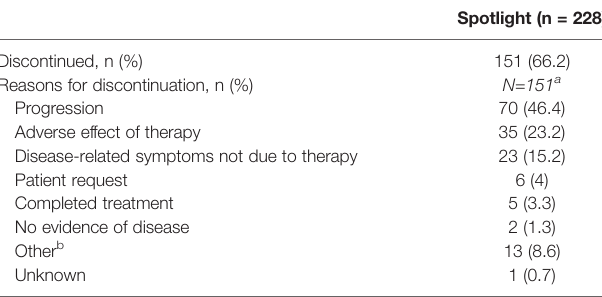
TABLE 4 | Summary of reasons for pembrolizumab discontinuation: Spotlight